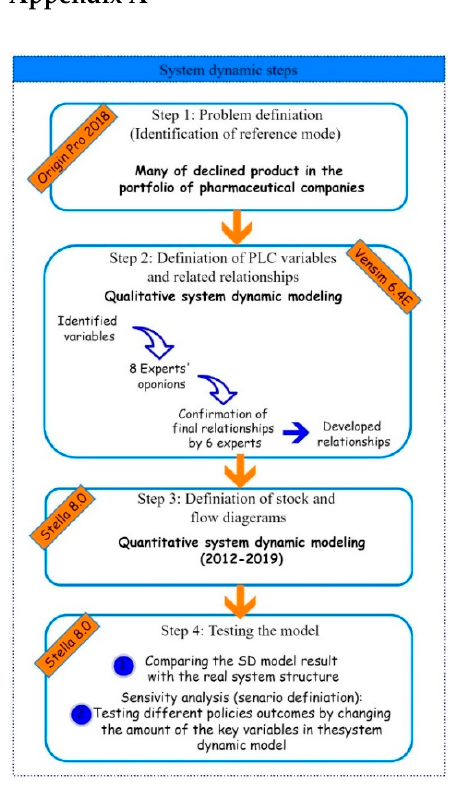
Figure A1. System dynamic modeling steps. Table A1. Product life cycle subsystems and related variables .